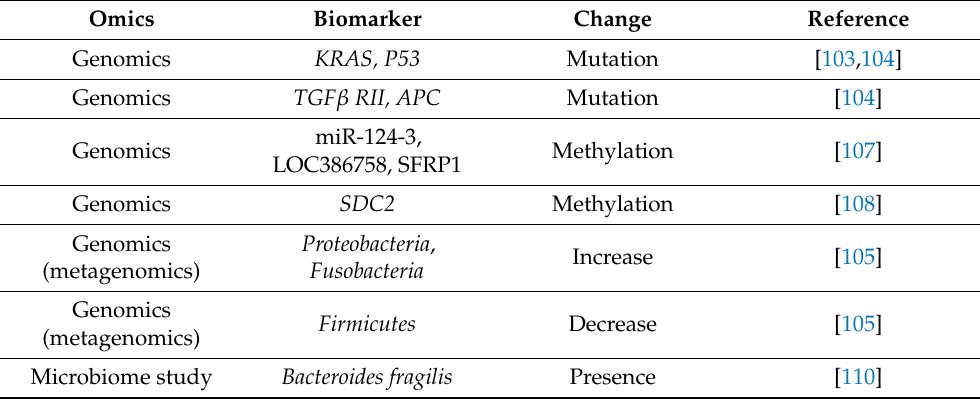
Table 5. Main biomarkers found in bowel lavage fluid samples of CRC patients with different omics